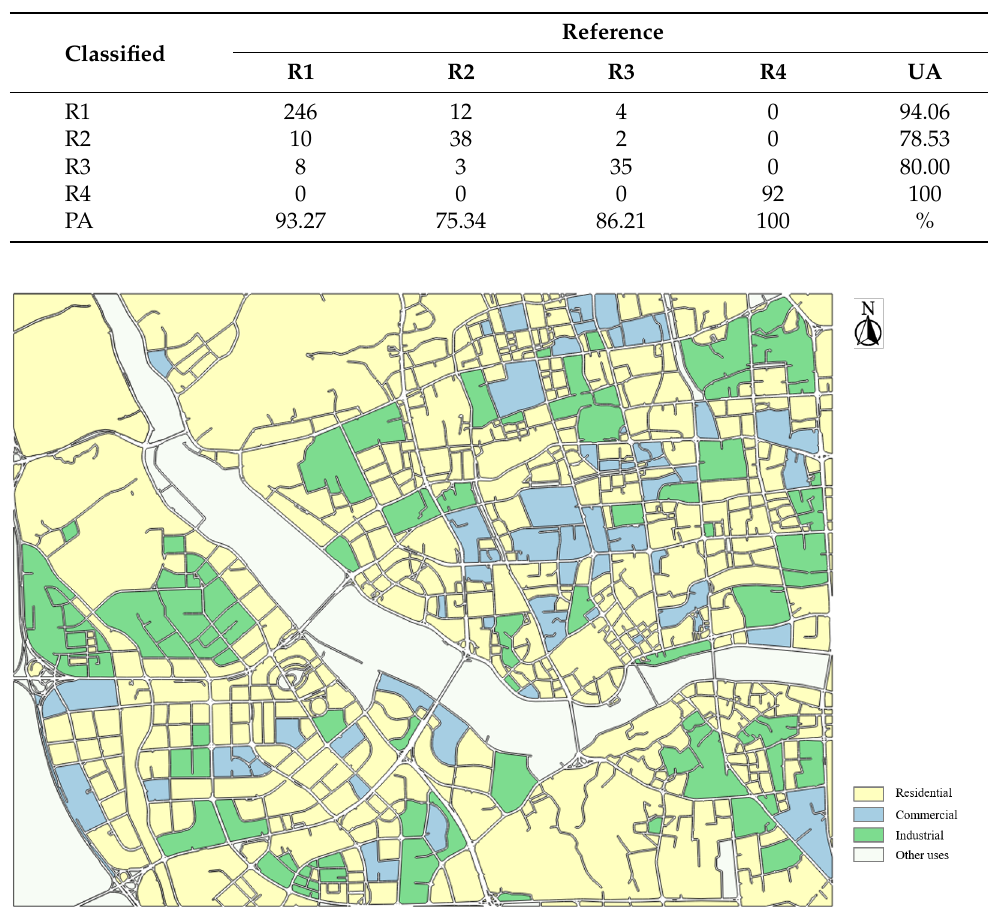
Figure 11. Urban functional region (UFR) classification results of the study